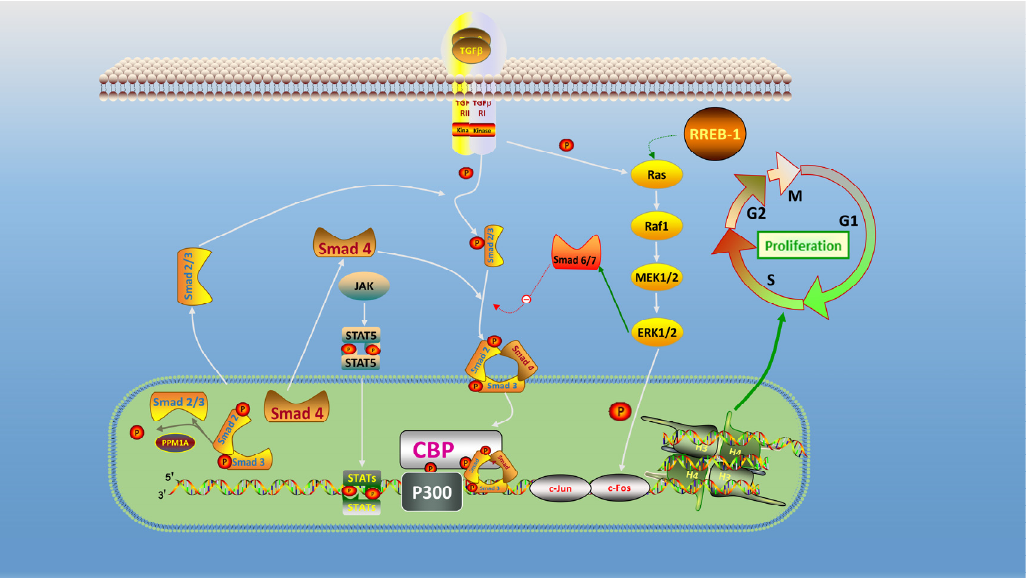
Figure 7. Relationships between TGF- β 1/Smads, MAPK and Jak/Stat pathways involved in cell proliferation. Cell proliferation and apoptosis strictly regulate the homeostasis of intestinal cells. Signaling-coupled pathways that activate and promote cell proliferation and inhibit apoptosis act through TGF- β and RREB in response to stimulation by internal and external survival factors. TGF- β /Smad, ERK-MAPK activates CBP/p300 to promote cell transcriptional proliferation. Activation of the Jak-Stat pathway that phosphorylates STAT5 negatively regulates cellular transcription and prevents excessive cell proliferation.